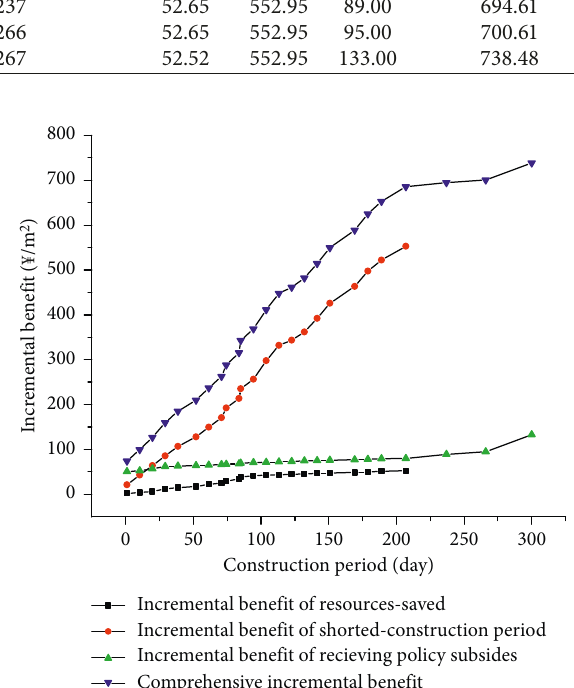
Figure 10: Changes in economic benefits over a project